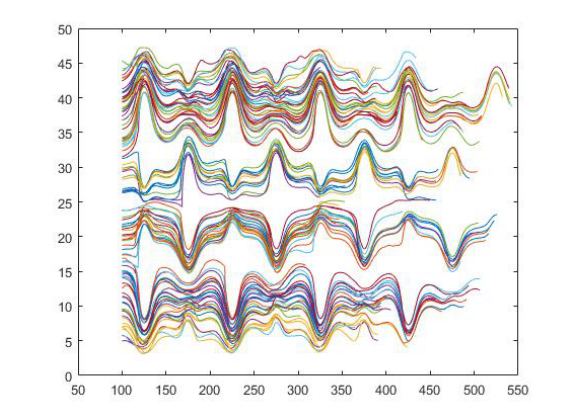
Fig. 20. Geometry A, 100 blood cells.